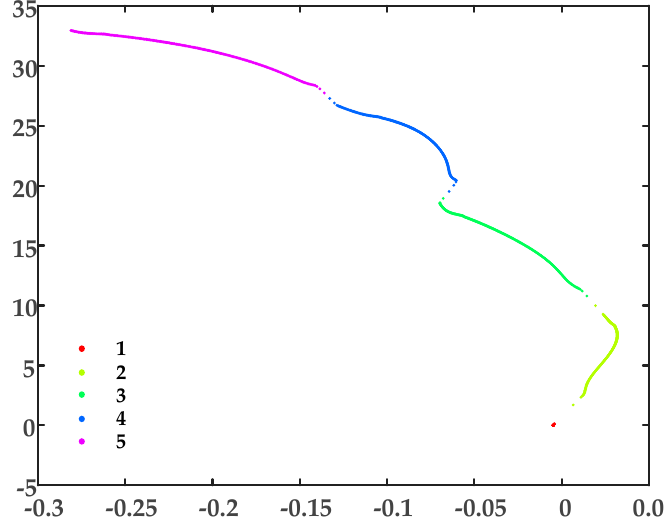
Figure 19. The DBSCAN clustering results for the MV cable sheath current matrix.